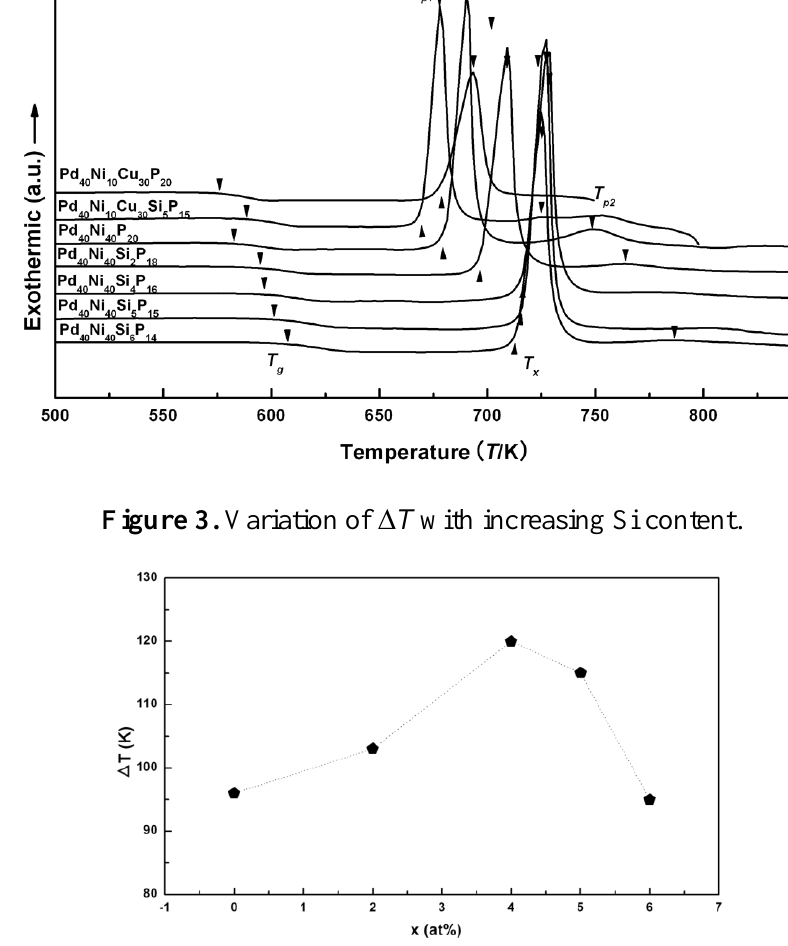
Table 2. Summary of the role of optimum amounts of metalloid element additions in various BMGs. Alloying